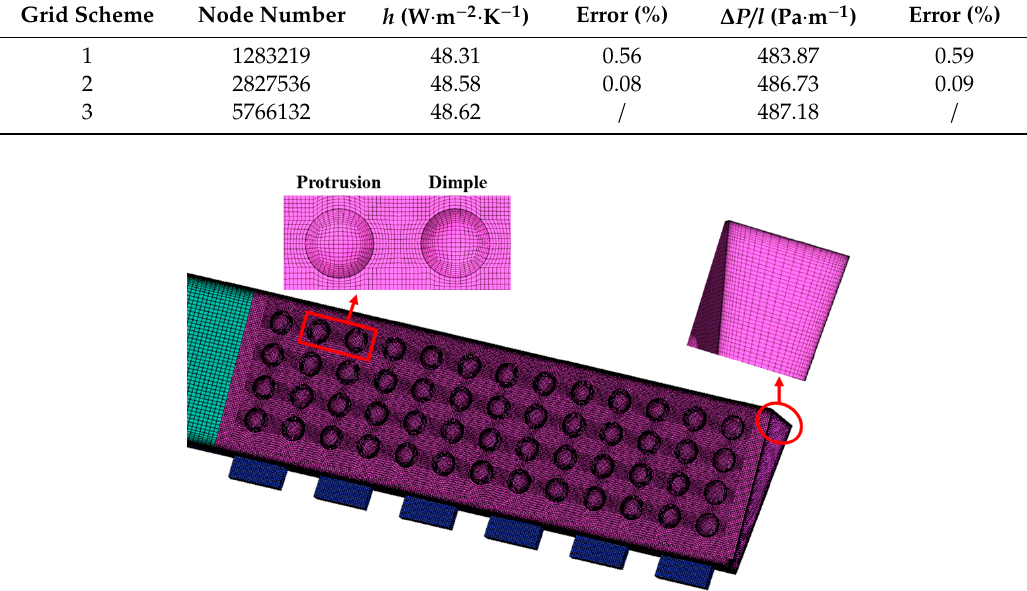
Figure 4. Mesh model of dimple-protrusion channel.